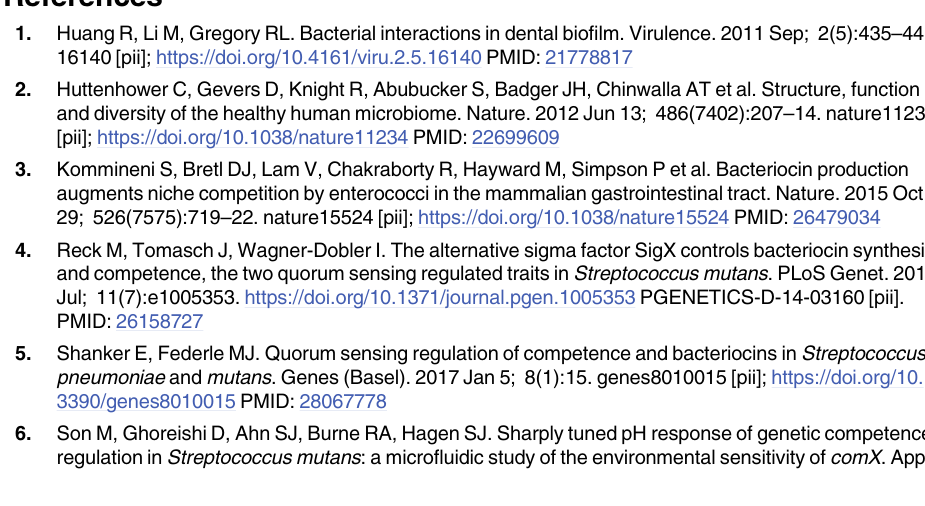
S1 Dataset. Specific experimental data used for mathematical model calibration and vali-